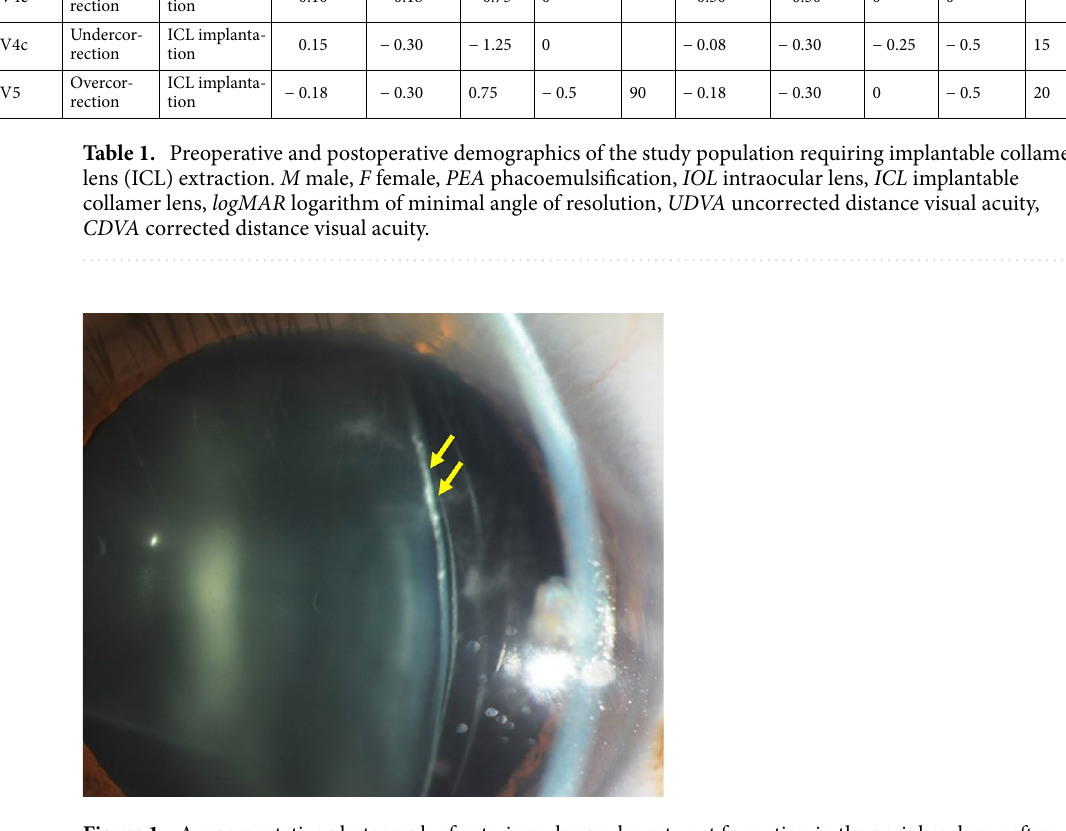
line lens was performed in 1 eye. In Group 2, ICL exchange to change the ICL power was performed in all eyes having residual refractive errors. Visual and refractive outcomes. Logarithmic minimum angle of resolution (logMAR) uncorrected dis- tance visual acuity (UDVA) improved, but not significantly, from 0.12 ± 0.26 preoperatively, to − 0.03 ± 0.37 post- operatively (Wilcoxon signed-rank test, p = 0.173). Of the 7 eyes targeted for emmetropia, 7 (100%) and 6 (86%) achieved UDVAs of 20/40 and 20/20 or better, respectively (Fig. 2). LogMAR corrected distance visual acuity (CDVA) improved significantly, from − 0.10 ± 0.27 preoperatively, to − 0.27 ± 0.06 postoperatively (p = 0.043). Three eyes (38%) showed no change in CDVA, 3 eyes (38%) gained 1 line, 2 eyes (25%) gained 3 or more lines, and no eyes lost any lines (Fig. 3). In Group 1, 3 eyes that gained 1 line or more in CDVA underwent cataract